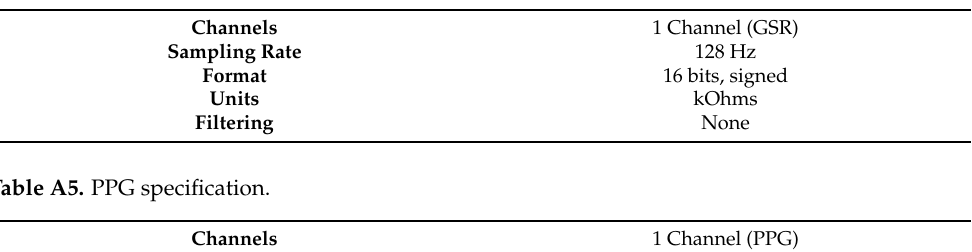
Table A4. GSR specification.